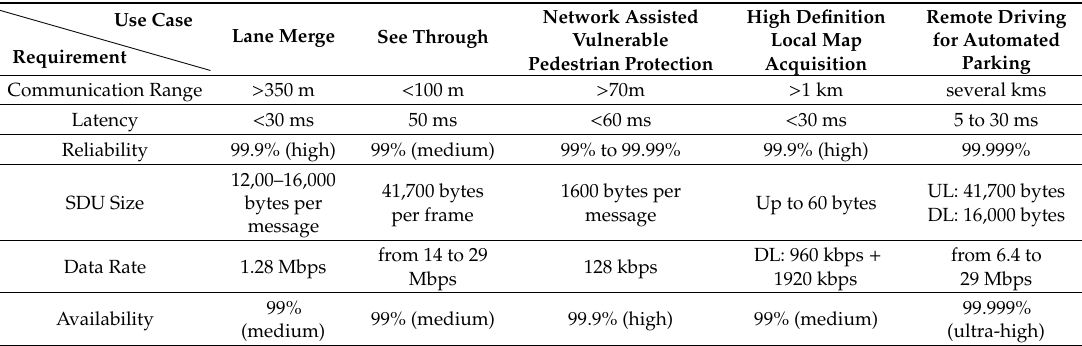
Table 2. Network requirements for the 5GCAR use